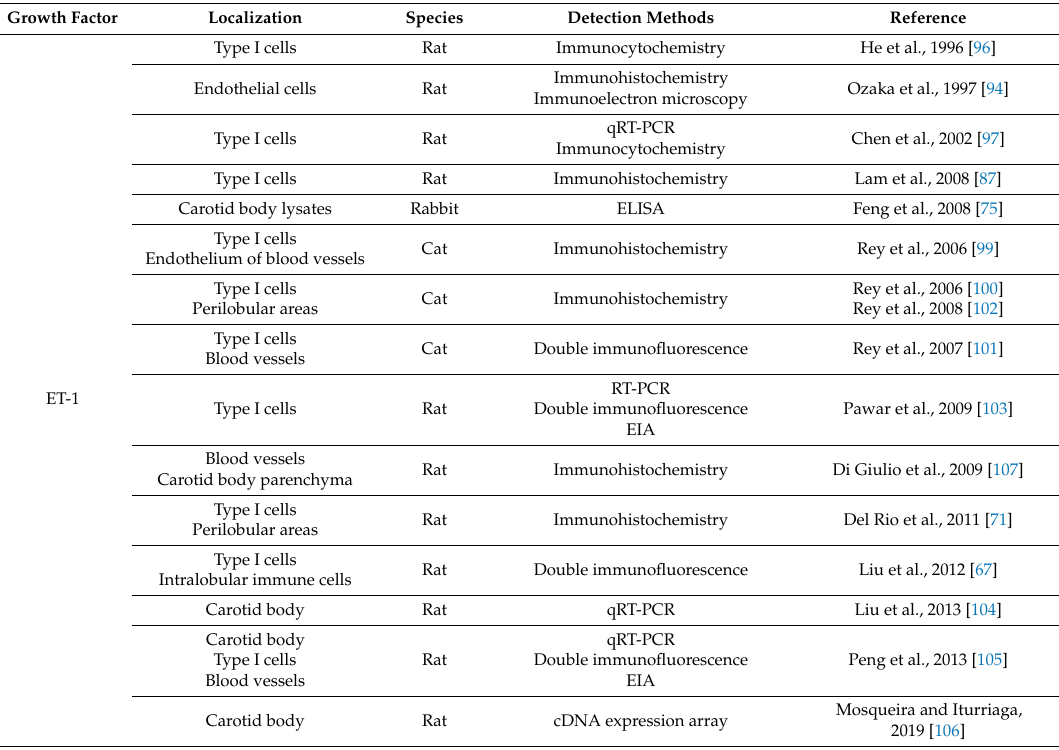
Table 11. Endothelins. Expression of ET-1 in the carotid body.